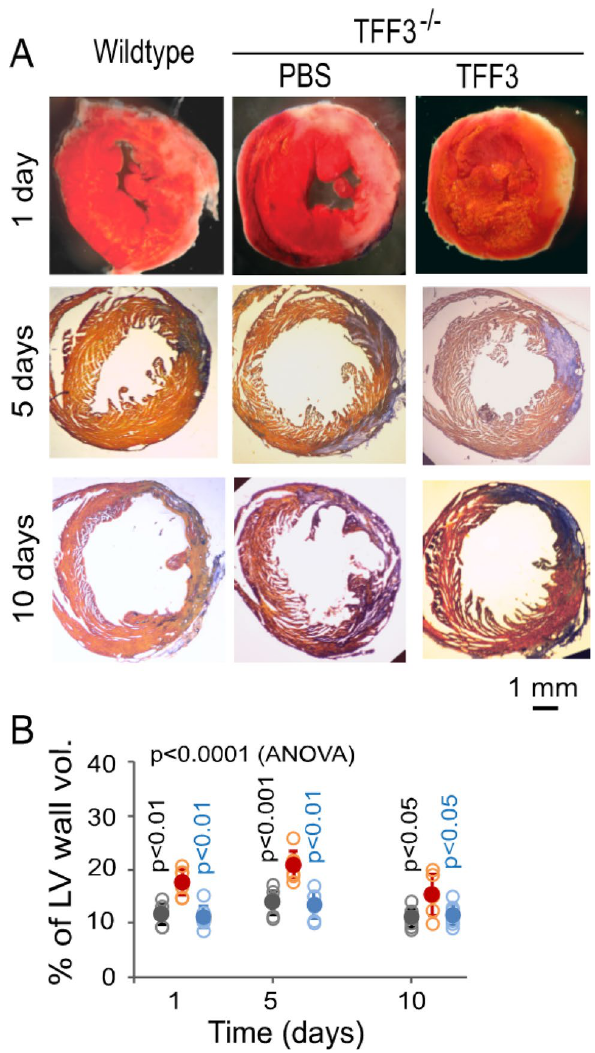
Figure 8. TFF3-mediated mitigation of myocardial infarction. ( A ) Left ventricular specimens treated with TTC for demonstrating acute myocardial infarcts (pale) at day 1 of MI-R injury and stained with orange red and methylene blue (AZAN assay) for showing myocardial fibrosis (blue) at day 5 and 10 of MI-R injury in wildtype and TFF3 −/− mice with PBS and recombinant TFF3 administrations into the ischemic myocardium immediately after coronary artery ligation. ( B ) Graphic representation of the influence of TFF3 on the level of myocardial injury. Solid dark gray, red, and blue circles: Means ± SDs from wildtype mice and TFF3 −/− mice with PBS and recombinant TFF3 administrations, respectively. Open dark gray, red, and blue circles: Raw data points (n = 6) from individual wildtype mice and TFF3 −/− mice with PBS and recombinant TFF3 administrations, respectively. The dark gray-colored p value at each time point is for comparison between the wildtype mice and TFF3 −/− mice with PBS administration. The blue-colored p value at each time point is for comparison between TFF3 −/− mice with PBS and recombinant TFF3